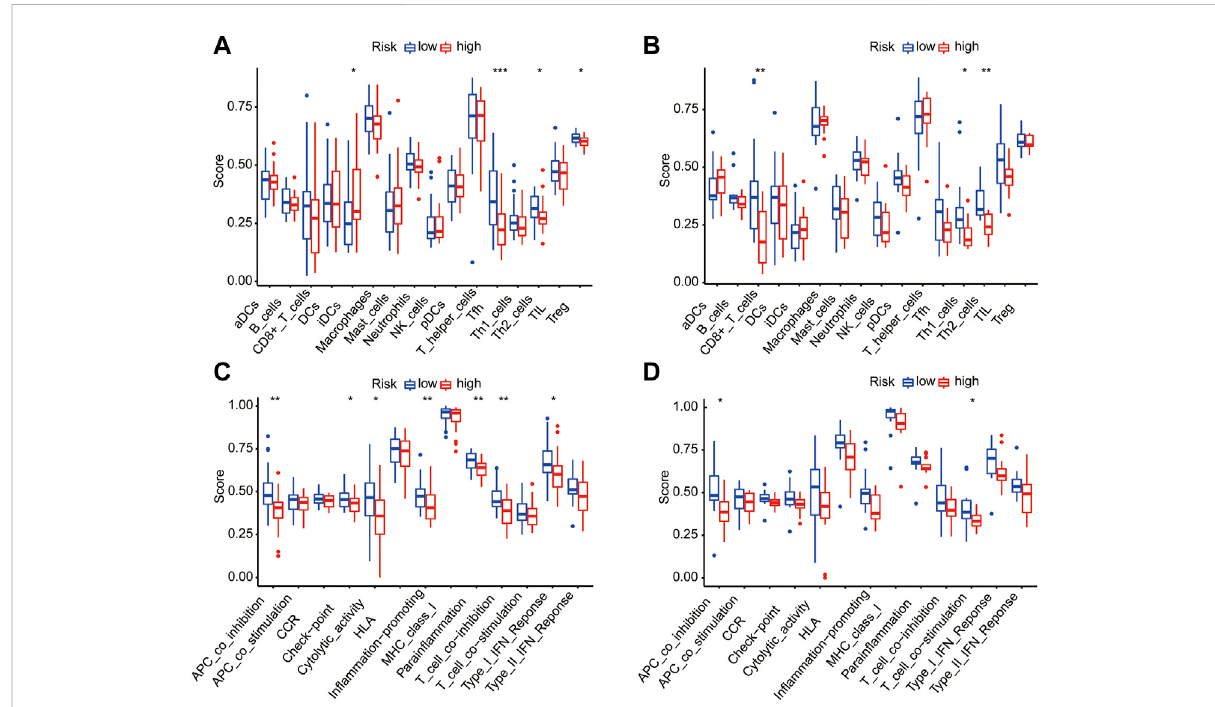
FIGURE 12 Correlationbetweenimmuneactivitiesandriskscoreintrainingandtestingdatasets. (A/B) Differenceofin fi ltratingimmunecellsubpopulations and levels between the two pyroptosis risk groups in the training dataset (A) and testing cohorts (B) . (C/D) The relationship between pyroptosis risk score and 13 immune-related pathway activities in the training dataset (C) and testing cohorts (D)